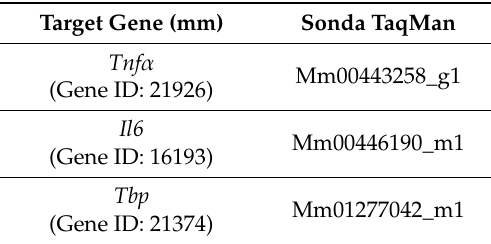
Table 2. The TaqMan ® probe used for